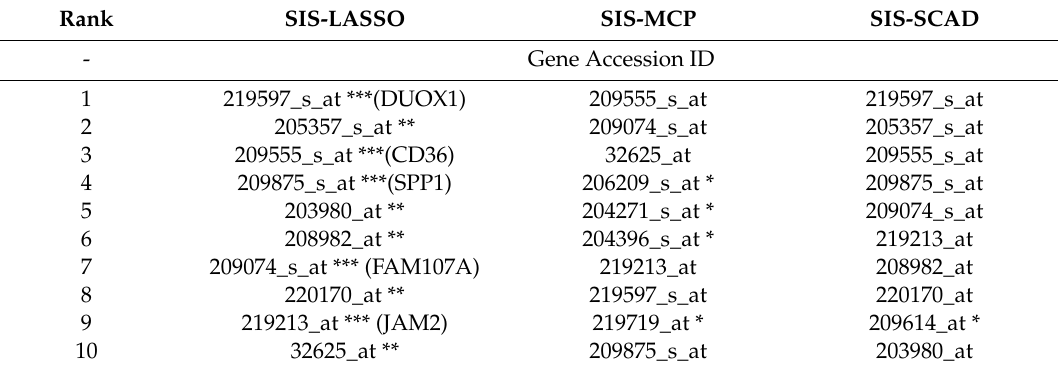
Table 5. Top 10 ranked genes with highest selection frequency from lists of gene ranking using 100 times resampling approach of three methods of SIS-LASSO, SIS-MCP, and SIS-SCAD on the lung cancer gene expression